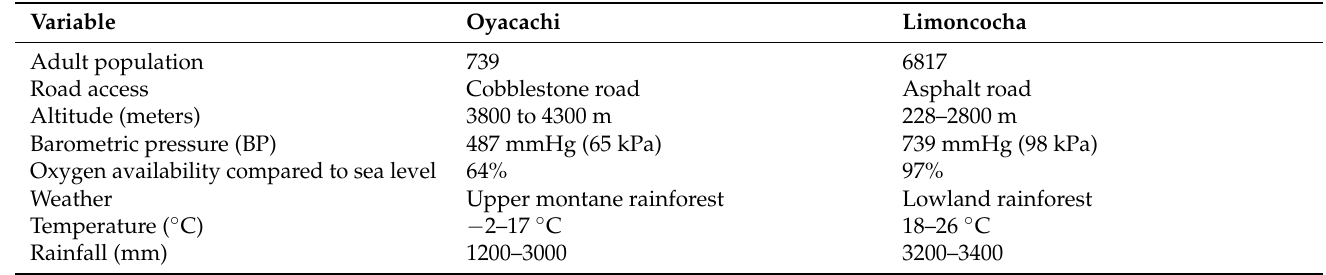
Table 2. Comparative table of main climatological and meteorological differences between Oyacachi and Limoncocha [17,31 – 34] .